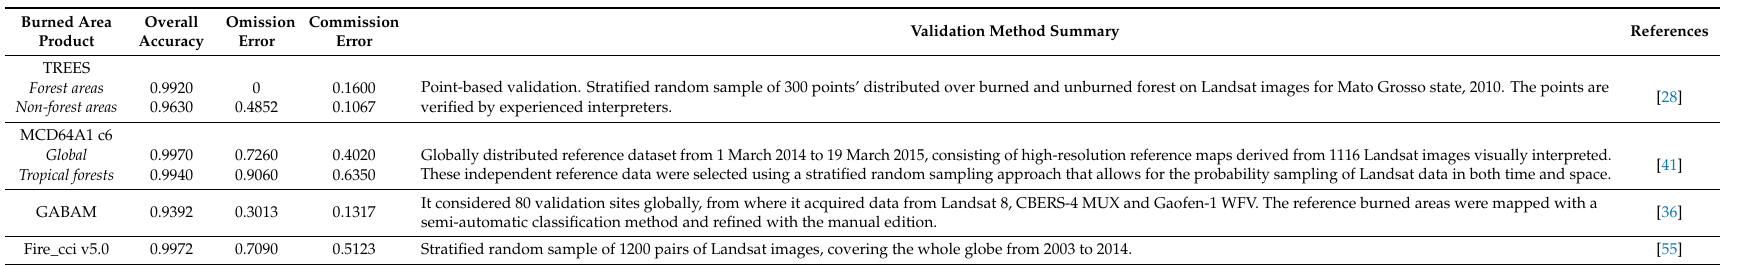
Table 2. Accuracy information of four burned area